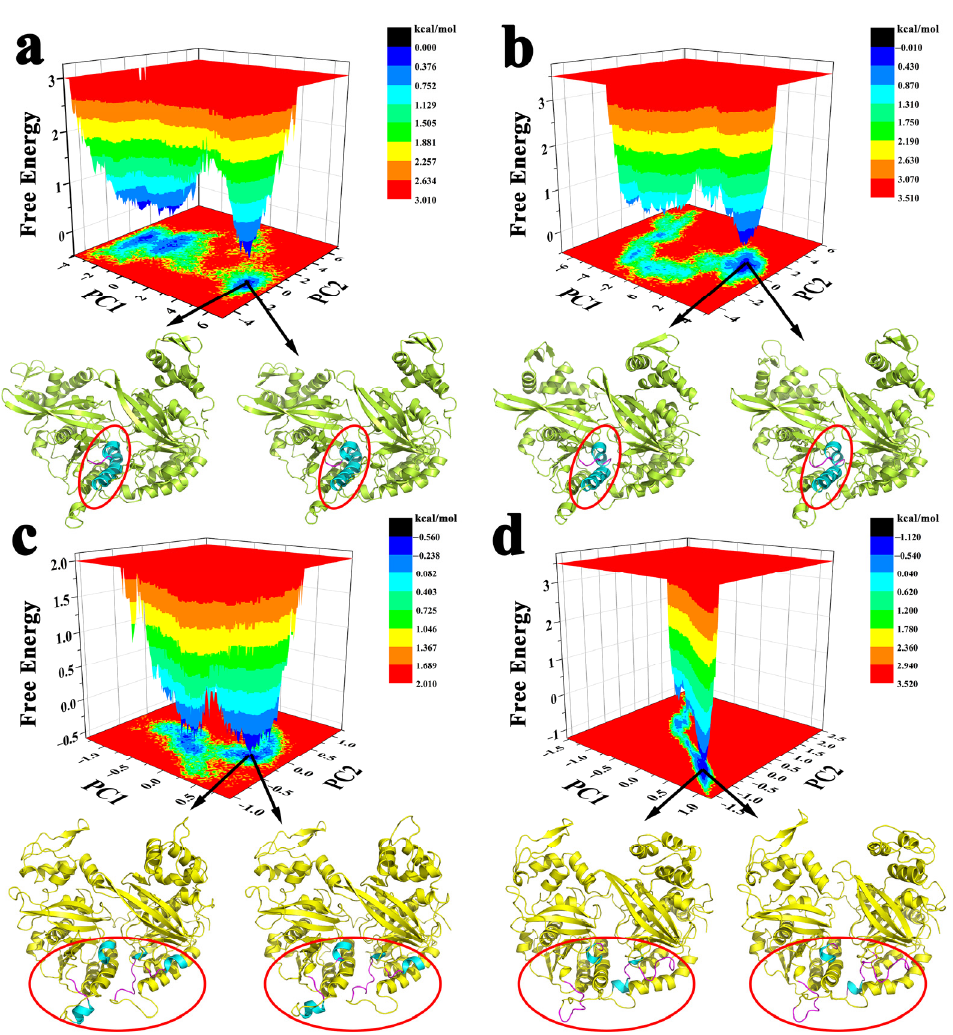
Figure 4. Free energy landscape and lowest energy conformations ( a ) 298 K RecA; ( b ) 310 K RecA; ( c ) 298 K UvsX; ( d ) 310 K UvsX. Comparing the lowest energy conformation of each protein at 298 K and 310 K, the regions with obvious differences are circled in red, and these parts of the protein are colored by secondary structure, with cyan as helix and the magentas as loop.